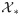
General image analysis pipeline comprised of Nop sequentially arranged processing operators.Each operator directly depends on the quality of the input images (I*) or features (X*) provided by its predecessor (adapted from [31]).